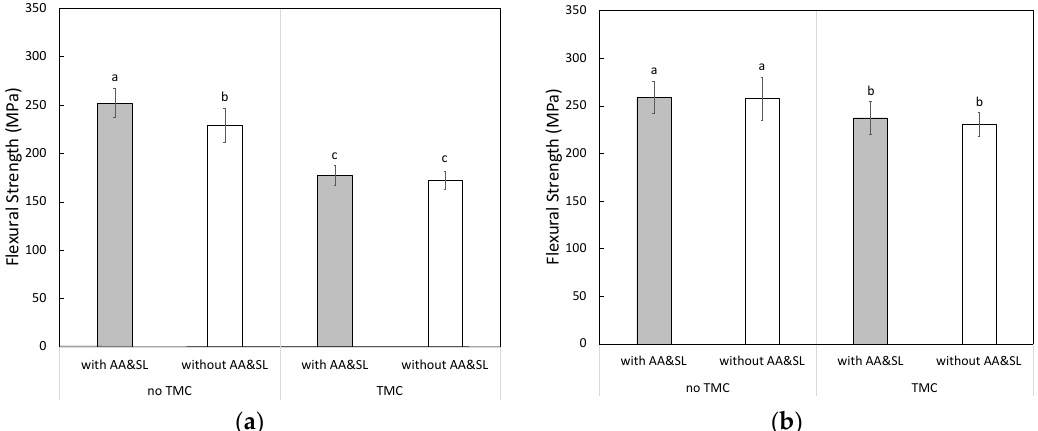
Figure 4. Mean flexural strength values of the bonded-double-bar specimens for ( a ) Shofu HC Hard (SH) and ( b ) Cerasmart 300 (CE), as illustrated in Figure 1b. The vertical error-bars indicate standard deviations. The di ff erent letters indicate a significant di ff erence between the groups ( p < 0.05, Tukey test, n = 12). AA&SL: alumina air-abraded and silanized specimen. TMC: 20,000-thermocycled specimen. No-TMC: 0-thermocycled specimen.